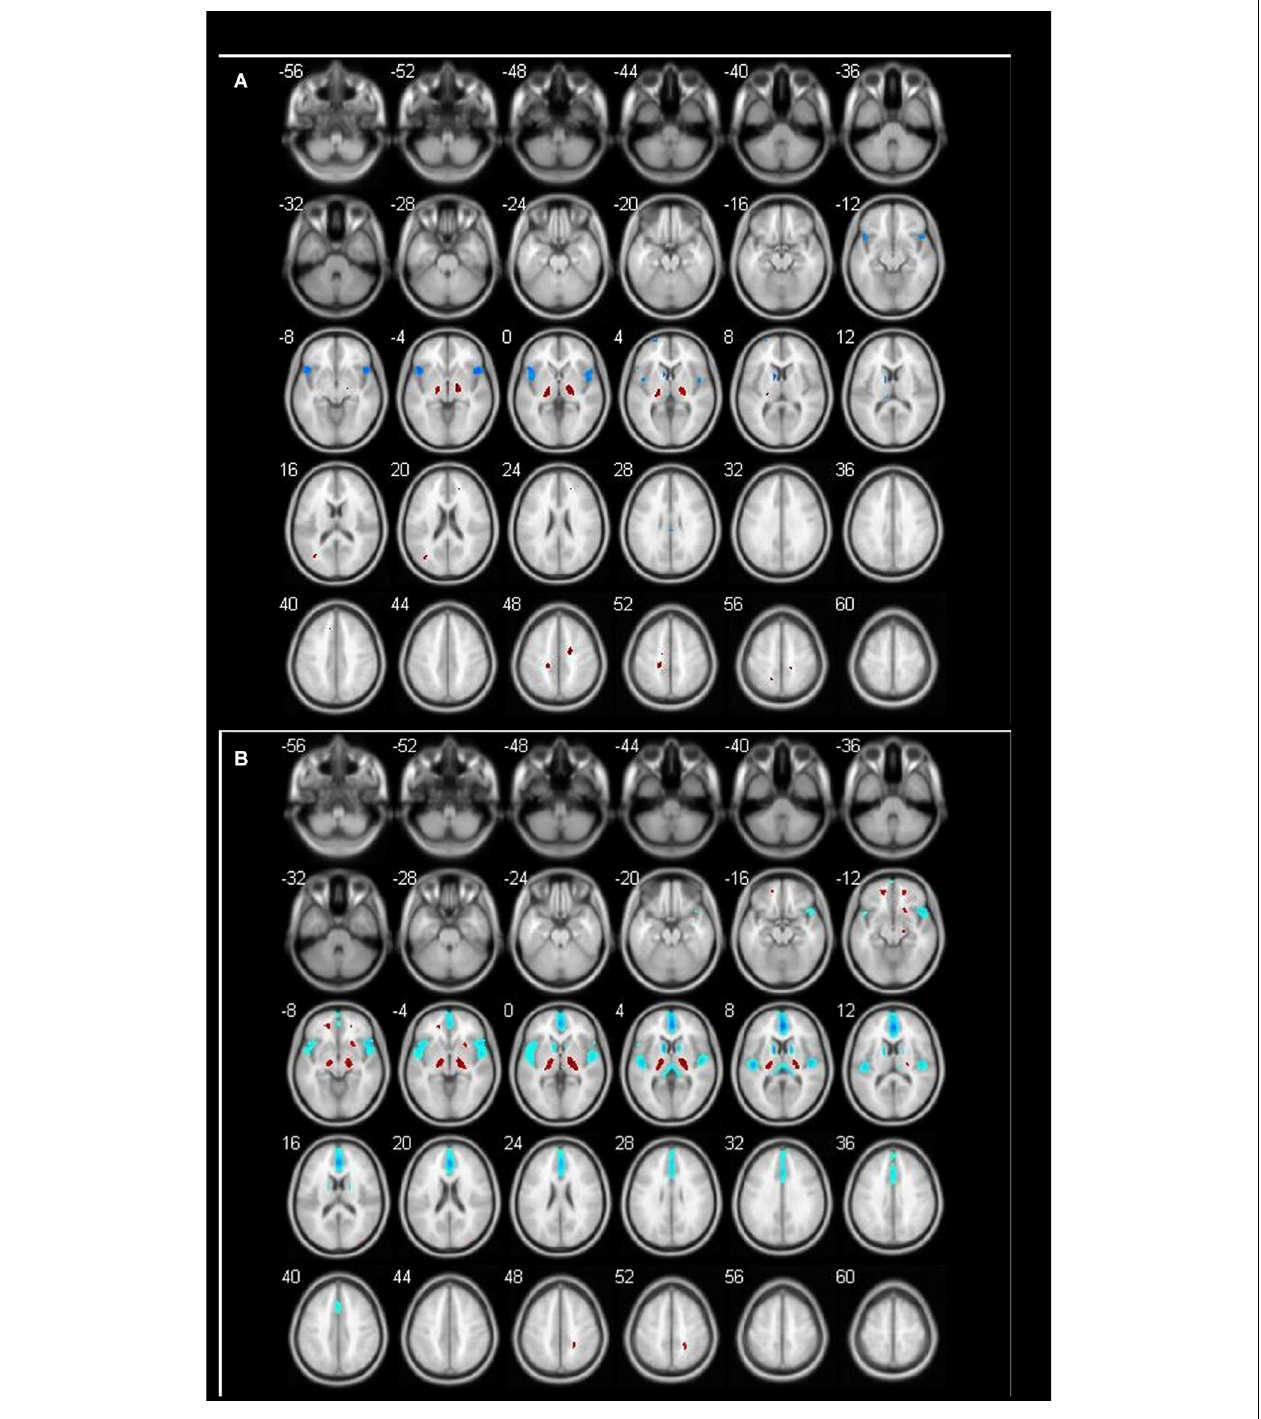
FIGURE 2 | Different brain regions in male groups (blue indicates decrease; red indicates increase). (A) Male 60–69 age group; (B) male 70–89 age